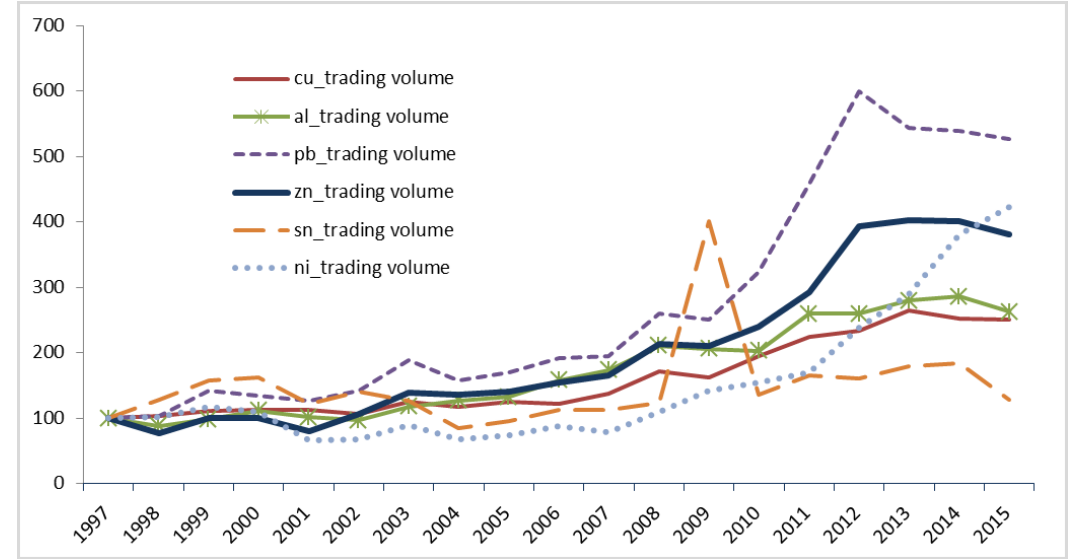
Figure 2. Plot of base metal trading volume (normalized by their 1997 values).